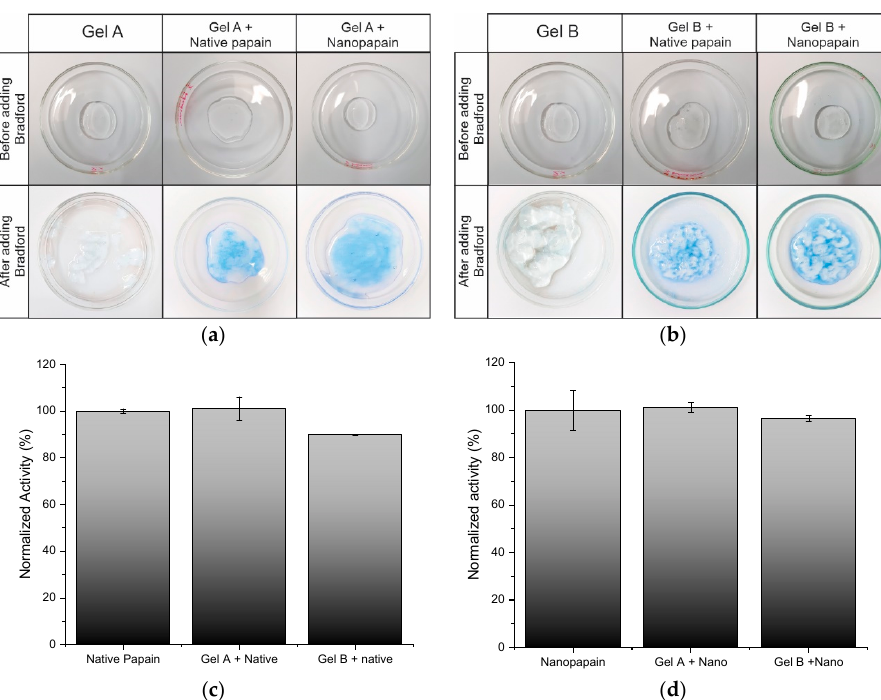
Figure 4. Protein distribution in formulations containing gel A ( a ) and gel B ( b ). Medium proteolytic activity measured of prototype formulations with native papain ( c ) and prototype formulations with papain nanoparticles ( d ) ( n = 3). Proteolytic activity was determined using Na-benzoyl-DL-arginine-p-nitroanilide Hydrochloride (BAPNA) as a specific substrate at 40 °C and absorbance was assessed at λ = 405 nm.